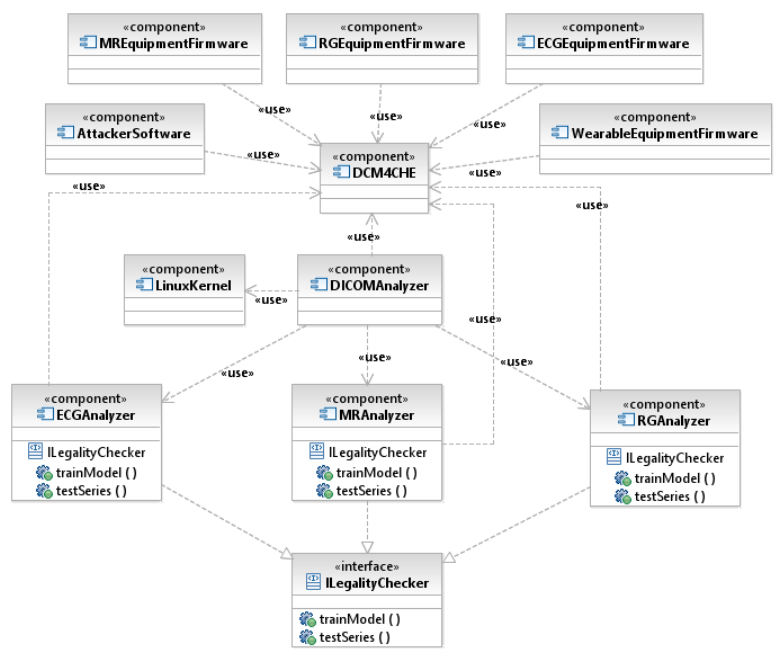
Figure 2. Component diagram of the subsystem for medical data analysis.